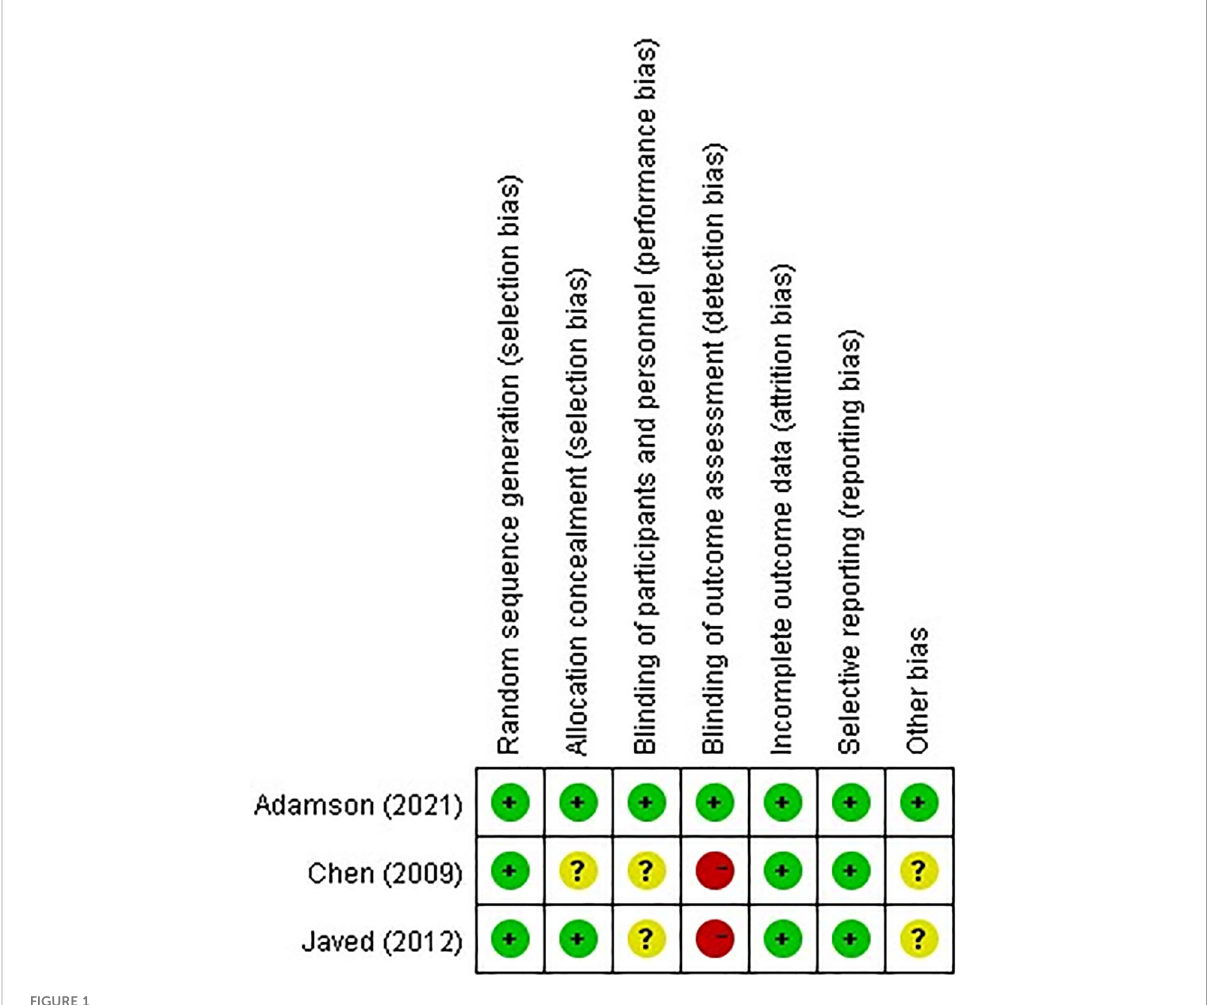
FIGURE 1 Risk bias assessment in the studies